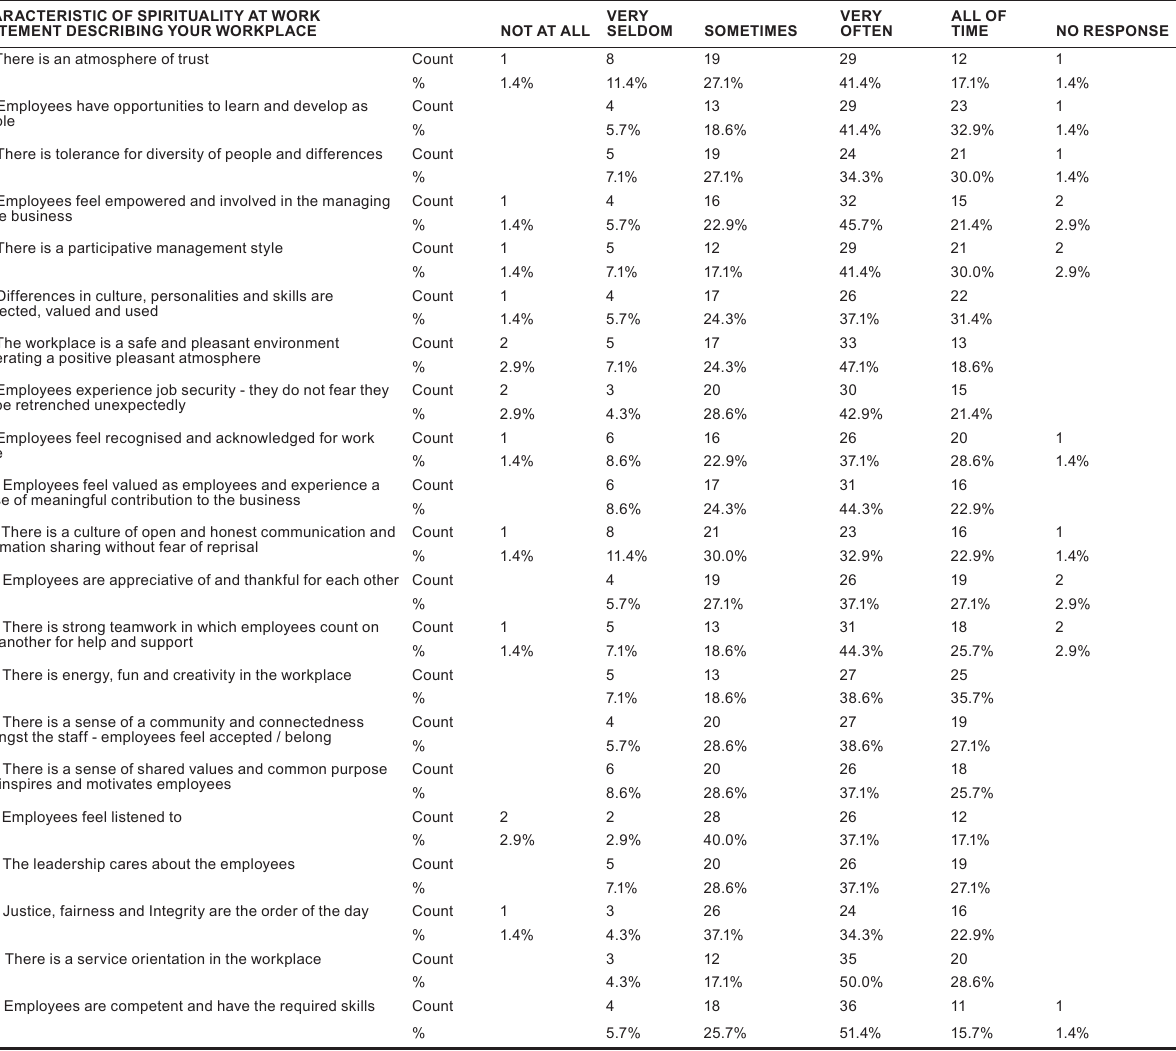
TABLE 9 Results of questionnaire A: A spiritual